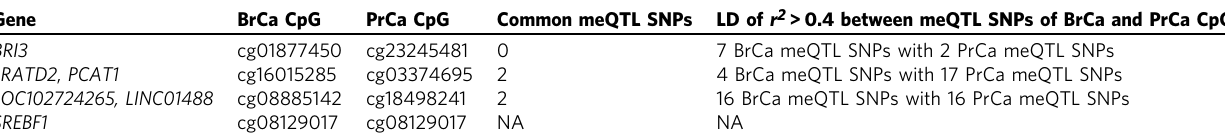
Table 5 Breast cancer (BrCa) and prostate cancer (PrCa) differentially methylated CpGs annotated to the same